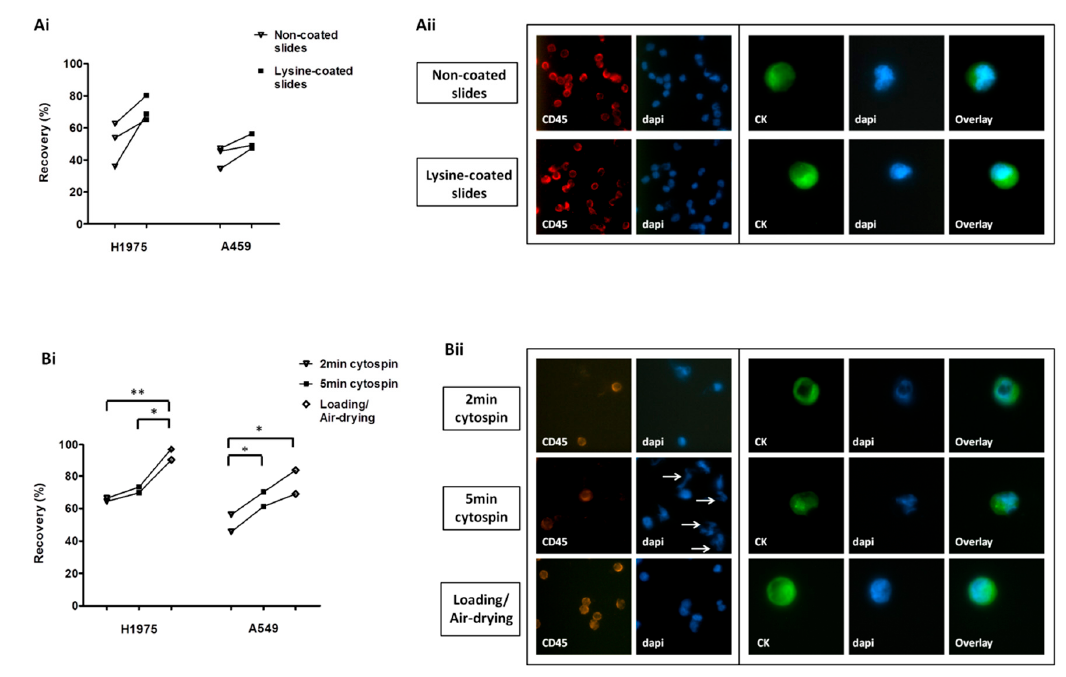
Figure 1. Optimization of cell harvest on slides for downstream protein expression analysis: ( Ai ) Recovery of pre ‐ labeled H1975 and A549 spiked cells transferred on lysine ‐ non ‐ coated and lysine ‐ coated SuperFrost Plus™ adhesion slides. ( Aii ) Immunofluorescence staining among lysine ‐ non ‐ coated and lysine ‐ coated slides; representative staining of leukocyte common antigen (CD45)/DAPI on peripheral blood mononuclear cells (PBMCs) and of cytokeratins (CK)/DAPI on non ‐ pre ‐ labeled A549 cells (Ariol microscopy system, Genetix, New Milton, UK) (400×). ( Bi ) Recovery of pre ‐ labeled cells using different cell harvest approaches. * , ** One ‐ way analysis of variance (ANOVA) test; statistical significance at the p < 0.05 level. ( Bii ) Representative CD45/DAPI staining on PBMCs and CK/DAPI staining on non ‐ pre ‐ labeled A549 cells (Ariol microscopy system, 400×) following their transfer on lysine ‐ coated slides with different approaches. Nuclear fragmentation indicated by arrows.